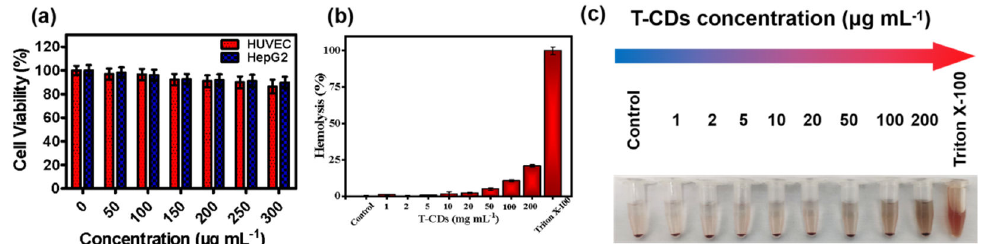
Figure 5. ( a ) MTT results of HUVEC and HepG2 cells viabilities after coincubation with T − CDs for 24 h at the different concentrations. ( b ) Hematological evaluation of RBCs treated with different dosages of T − CDs. The 1% Triton X − 100 − treated group was set as the positive control. ( c ) Photo- graphs of RBCs treated with different dosages (0, 1, 2, 5, 10, 20, 50, 100 or 200 μg mL −1 ) of T − CDs and Triton X − 100.